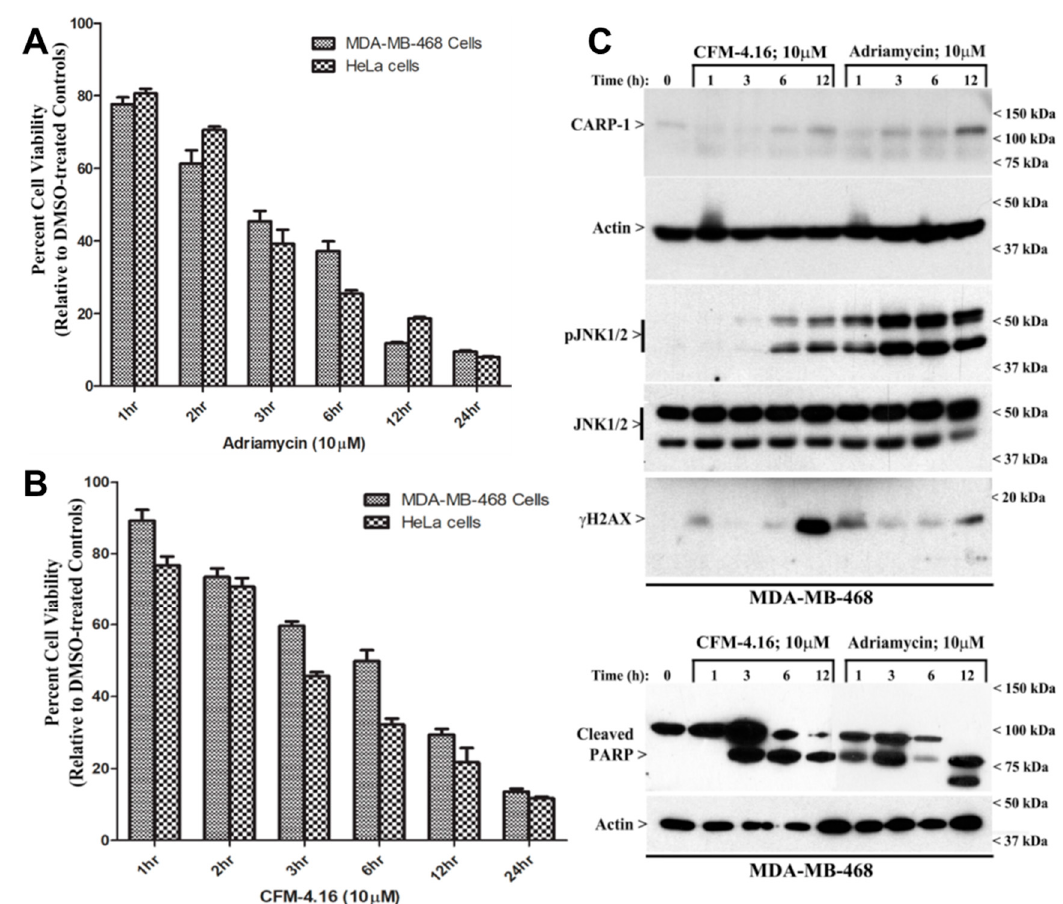
Figure 1. Adriamycin and CFM-4.16 inhibit cell growth, elevate CARP-1 expression, and induce activation of JNKs and H2AX, and apoptosis. Noted cell lines were either treated with DMSO (Control), Adriamycin ( A ), or CFM-4.16 ( B ) for indicated dose and time. Cell viability was determined by MTT assay. The columns in the bar charts represent means of three independent experiments; bars, SE. ( C ) MDA-MB-468 cells were either untreated (noted as 0), or treated with Adriamycin or CFM-4.16 for noted dose and time. Cell lysates were analyzed with WB as described in Section 2 for levels of CARP-1, phospho- and total JNK1/2, γ H2AX, and cleaved PARP. The WB membranes were subsequently probed with anti-actin antibodies to assess equal loading. In panel C, representative autorads out of two independent experiments is presented. The presence of respective protein is indicated by an arrowhead on the left side of each blot. The approximate location of various molecular-weight markers is indicated on the right side of each blot; kDa, kilodalton.